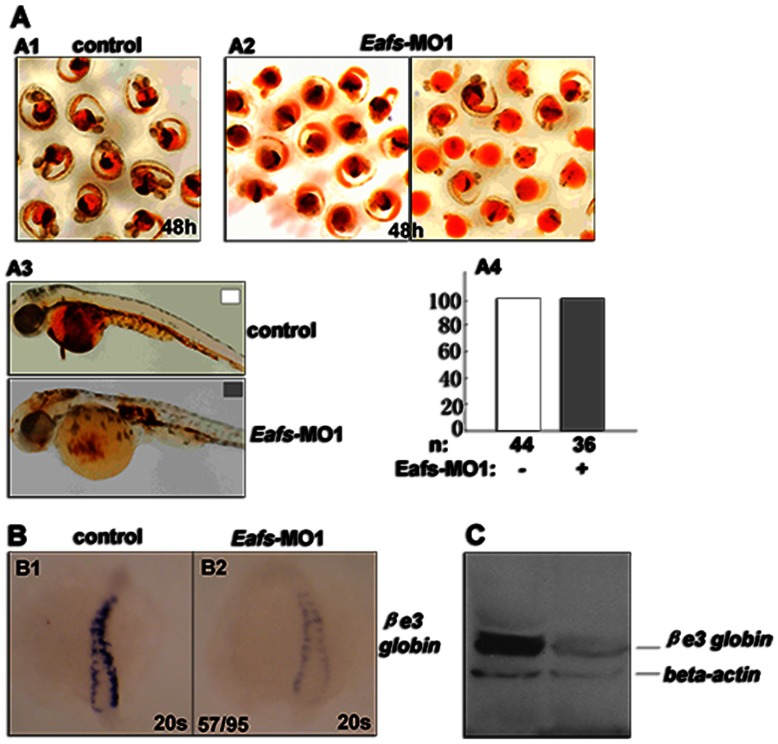

Eafs are required for specification of erythroid cells.(A) Erythroid defects in eafs morphants were detected by o-dianisidine staining for hemoglobin. (B) Eafs morphants displayed erythroid defects, indicated by reduced mRNA of βe3 globin. (C) Eafs morphants displayed reduced protein of βe3 globin.